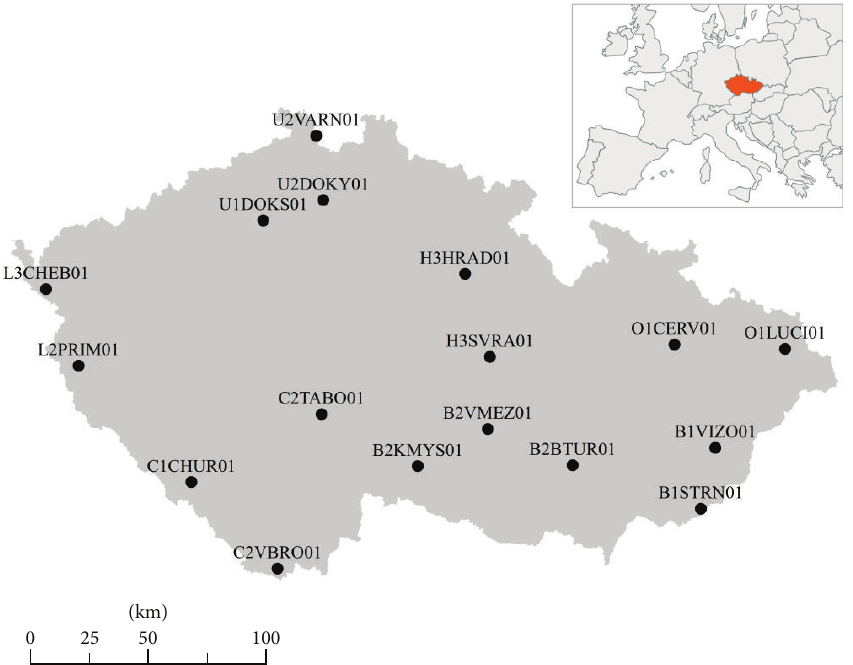
Figure 1: The location of stations used for the